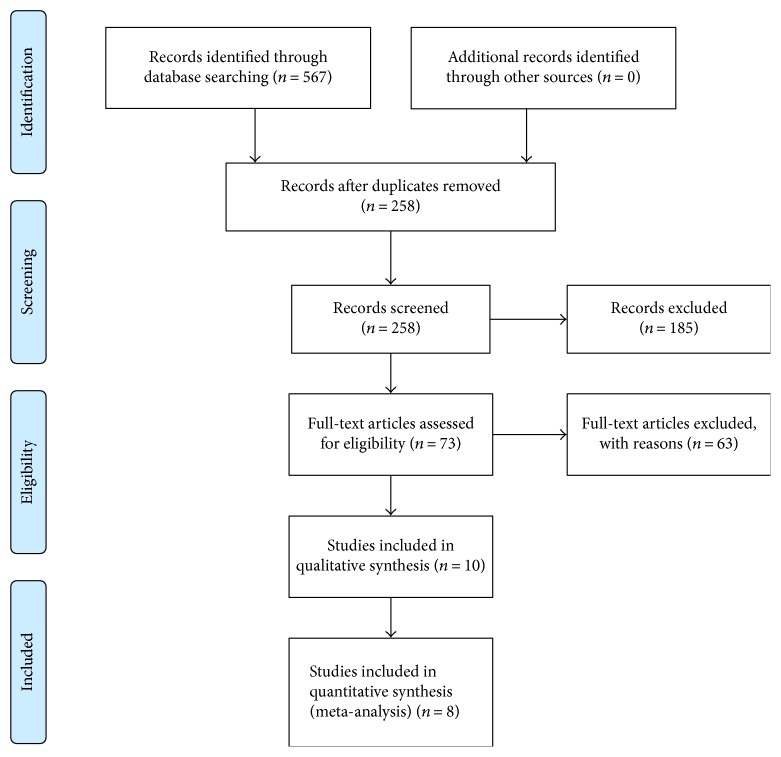
Flow chart of study selection [37].